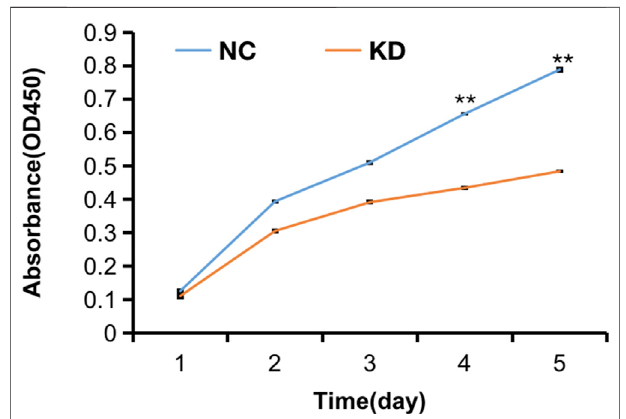
FIGURE 11 | CCK8 assay of HBVSMCs transfected with hsa_circ_0005505 shRNAs or negative control were performed to evaluate cellproliferationability.KD (cid:1) knockdownofhsa_circ_0005505,NC (cid:1) negative